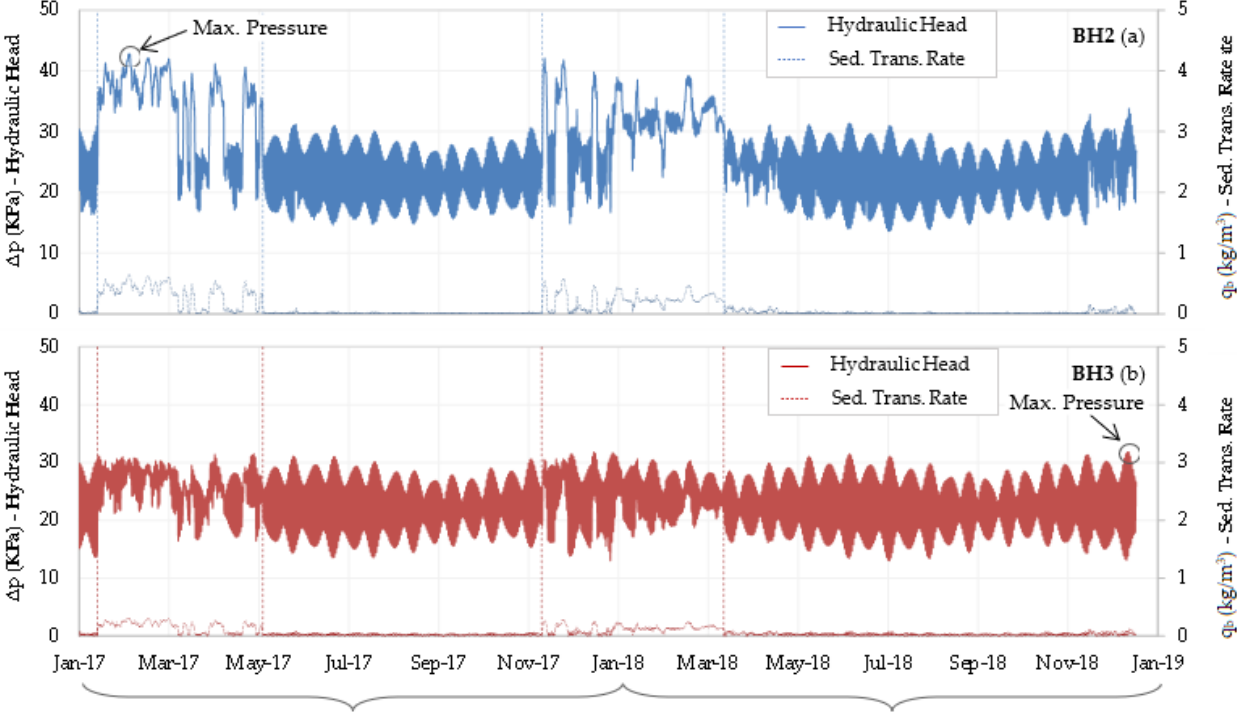
Figure 10. Loading condition by hydraulic head (left y-axis) and sediment transport rate (right y-axis) at BH2 ( a ) and BH3 ( b ).